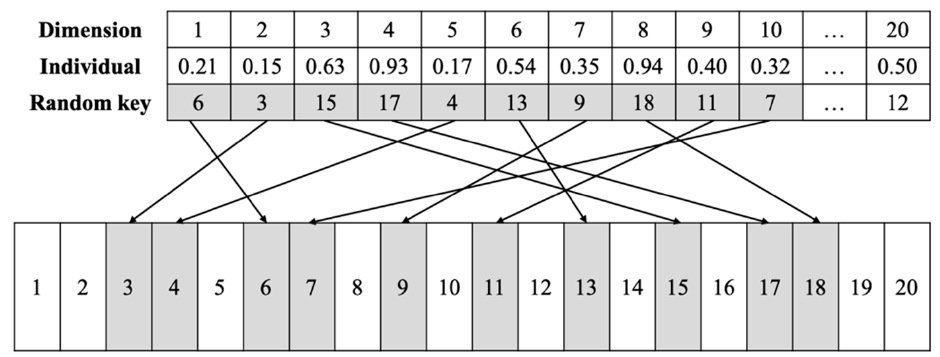
Figure 14. Allocating components to the feeder station.